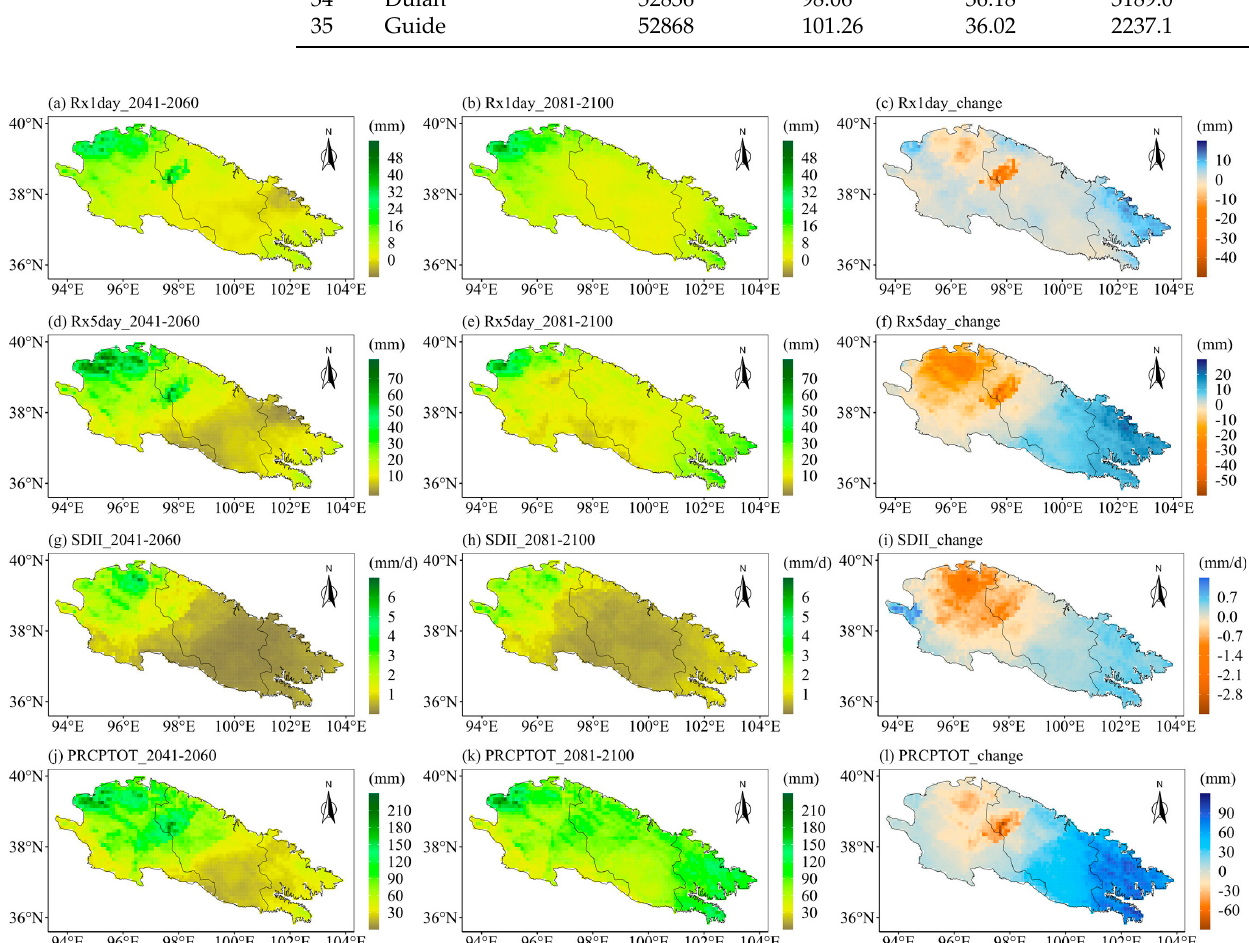
Figure A2. ( left ) The changes of extreme precipitation indices in the middle of the 21st century as compared to the base period, ( middle ) the changes of extreme precipitation indices at the end of the 21st century as compared to the base period, and ( right ) the changes of extreme precipitation indices at the end of the 21st century as compared to the middle of the 21st century. Spatial distribution over the Qilian Mountains under SSP245: ( a – c ) Rx1day, ( d – f ) Rx5day, ( g – i ) SDII, and ( j – l ) PRCPTOT. Note that the future change is represented by the ensemble of the corrected CMIP6 models. Table A1. Location information of the basic weather stations.